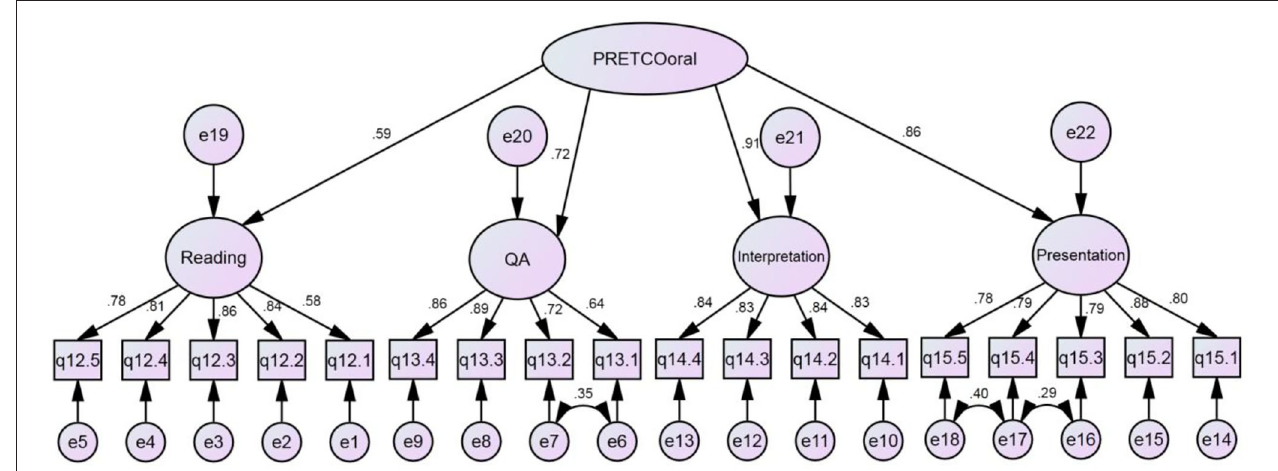
FIGURE 5 | Hypothetical model 2 of PRETCO-oral based on questionnaire data.